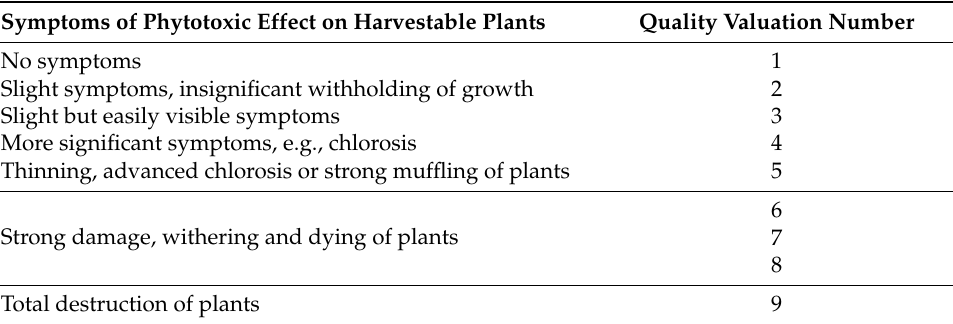
Table 4. Quality valuation of herbicide influence on plants according to the 9-grade EWRC scale.